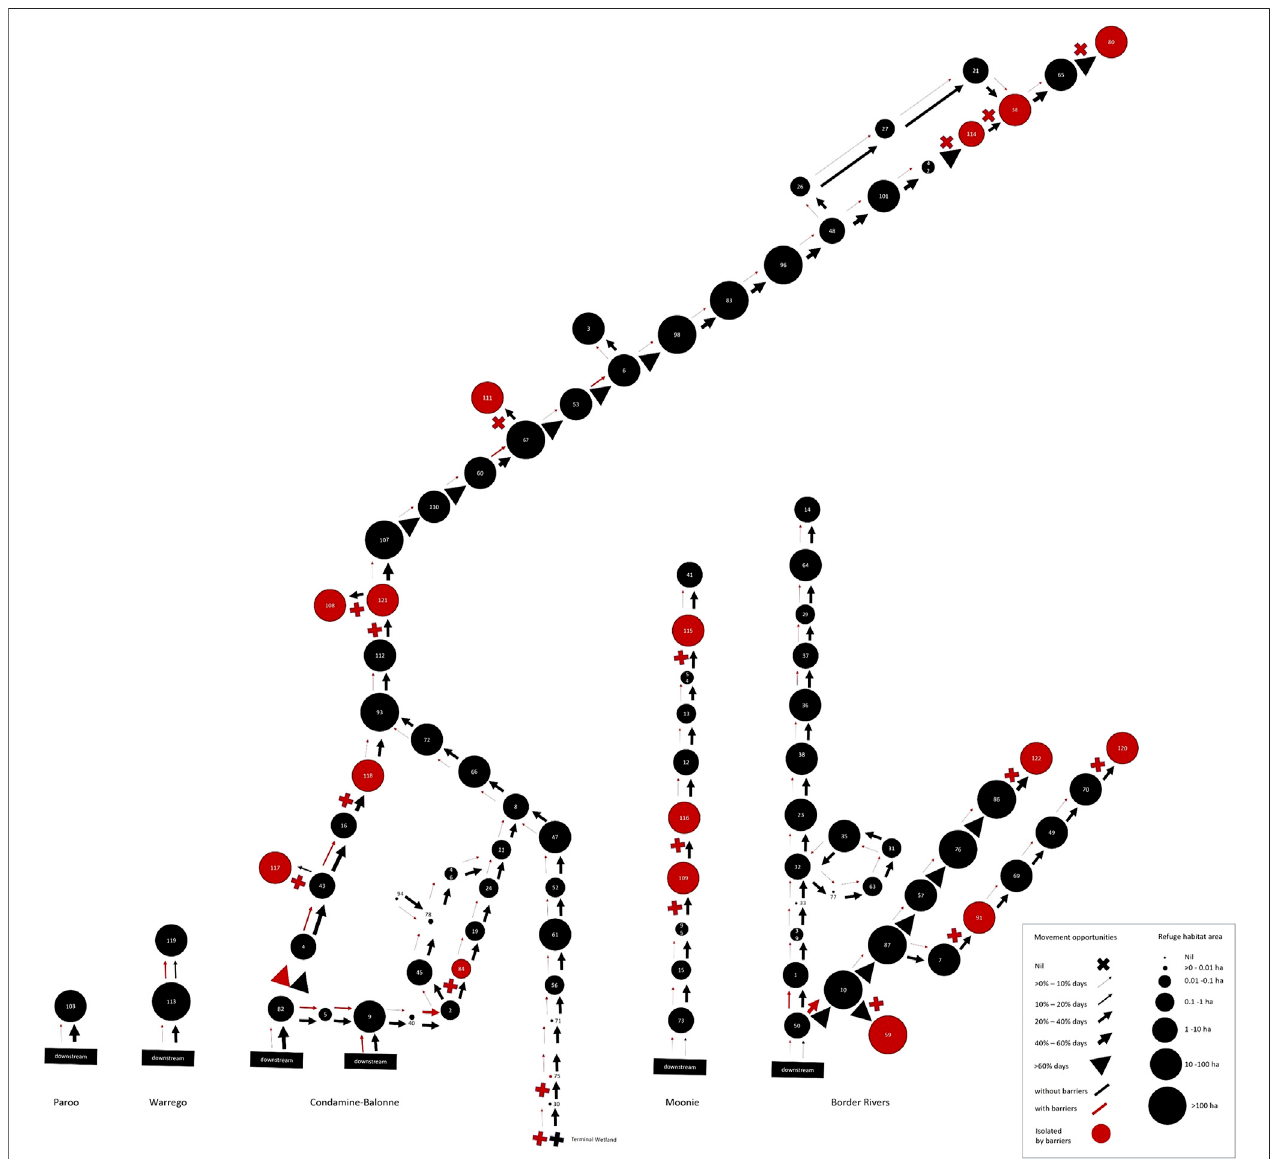
FIGURE 6 | Spatial, patch-based graph representing both peak drought waterhole availability per river segment as the size of the circles, and magnitude of long- term fi sh movement opportunities past segment-de fi ning barriers as the thickness of arrows (or crosses for impermeable barriers), both in the hypothetical absence of barriers (black arrows) and with barriers (red arrows and crosses). Red circles indicate river segments isolated by barriers. This illustrates the combined, long-term resistance and resilience risks to local fi sh populations across the QMDB region.